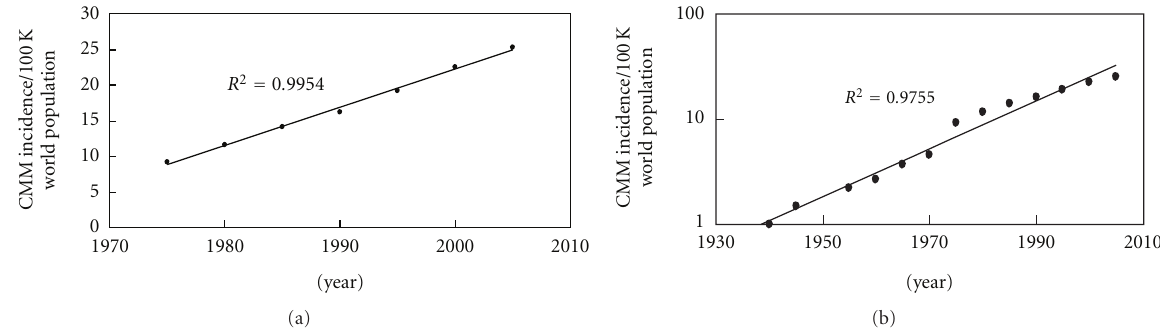
Figure 4: (a) The SEER 9 data from 1975 to 2007 indicates a linear increasing incidence in CMM ( R 2 is 0.9954). Five years of data was averaged to obtain each data point, for example, the data point for 1975 includes averaged data from 1973 to 1977. If the data is plotted out year by year the trend line and R 2 values indicate it is a linear increase since 1973. Even if we add the IARC data for 1960, 1965, and 1970 to the SEER data, the incidence is still increasing in a linear manner from 1960 to 2005. (b) However, if one adds in the data for Connecticut and New York State extending it back 6 decades to 1940, then the increase appears to be exponential ( R 2 is 0.9755) rather than linear ( R 2 is now